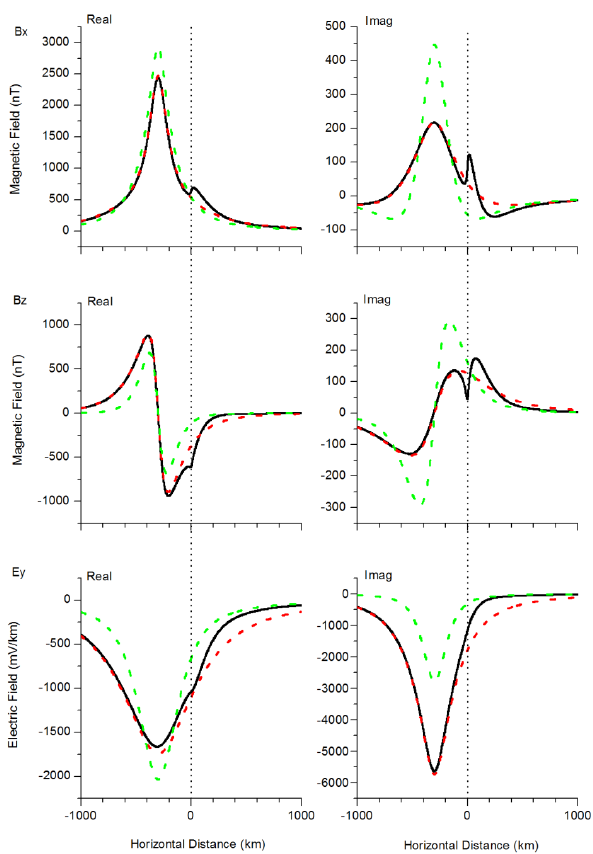
Fig. 11. Same as Fig. 9 but the line current is displaced from the interface region to x = 300km. 300 km. 3